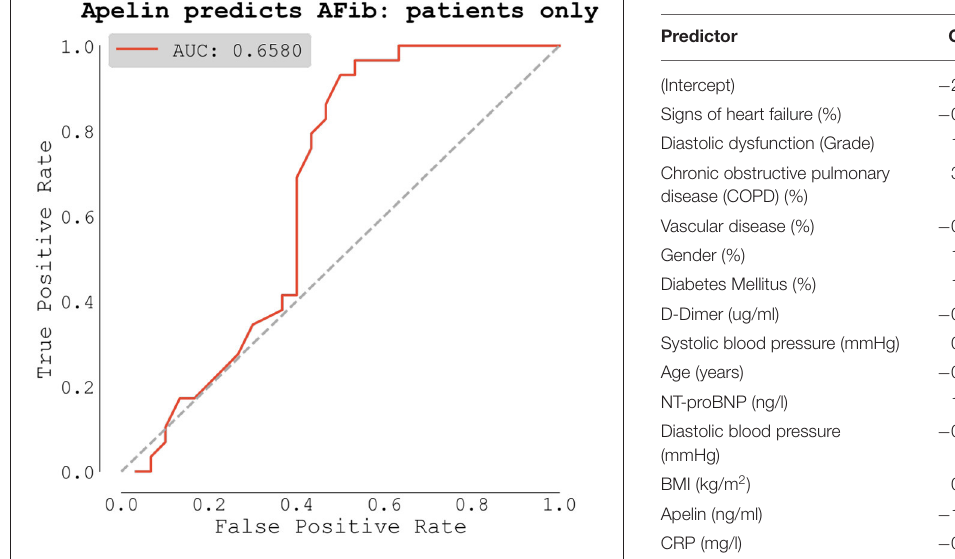
TABLE 3A | Logistic regression model for AF predictors.